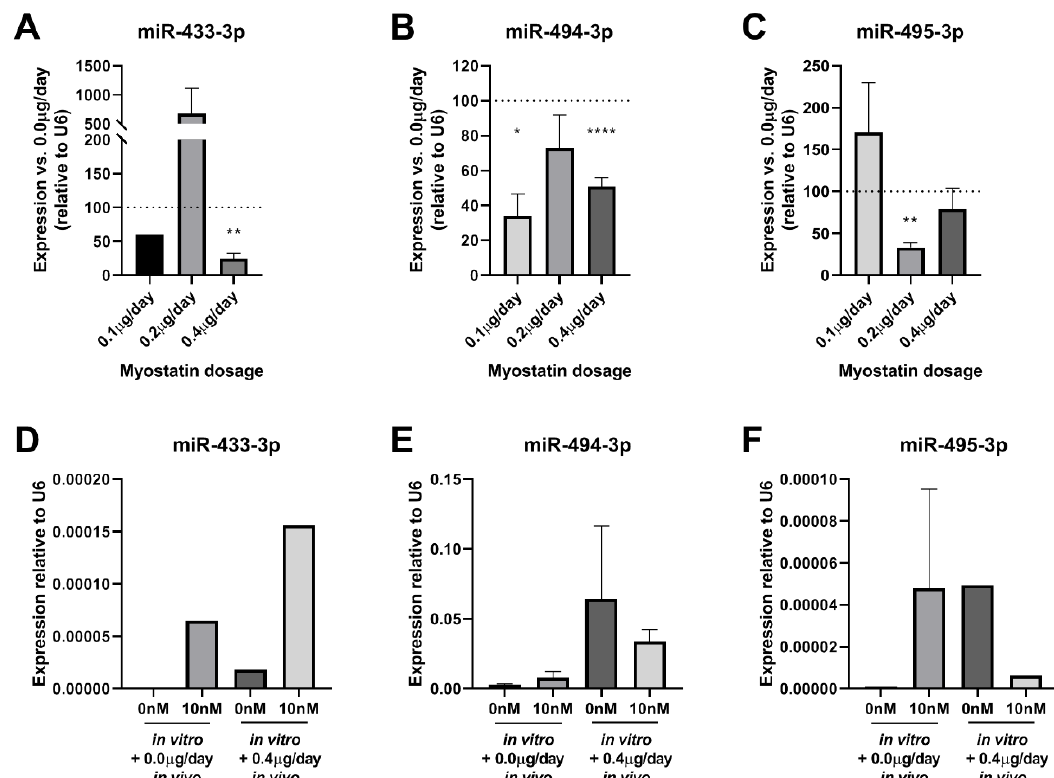
Figure 8. ( A – F) : microRNA expression in femoral arteries and macrophages. ( A )—miR-433-3p expression in femoral arteries of 0.1, 0.2, 0.4 µ g / day of myostatin relative to control mice (100%) showed significant downregulation of miR-433-3p at 0.4 µ g / day ( p = 0.003). ( B )—miR-494-3p expression in femoral arteries of 0.1, 0.2, 0.4 µ g / day of myostatin relative to control mice (100%) showed significant downregulation of miR-494-3p at 0.1 ( p = 0.001) and 0.4 µ g / day ( p < 0.0001). ( C )—miR-495-3p expression in femoral arteries of 0.1, 0.2, 0.4 µ g / day of myostatin relative to control mice (100%) showed significant downregulation of miR-495-3p at 0.2 µ g / day ( p = 0.0003). For ( A –C) Mean expression is shown and error bars represent SEM ( n = 8 for 0.0, 0.1 and 0.4 treatment groups, n = 6 for 0.2 treatment group). One-sample t-test performed with 100% expression of control group. * p < 0.05, ** p < 0.01, **** p < 0.0001. ( D )—miR-433-3p expression did not show any di ff erences between groups. ( E )—miR-494-3p expression did not show any di ff erences between groups. ( F )—miR-495-3p expression did not show any di ff erences. For ( D – E ) bone marrow monocytes matured into macrophages from in vivo treated mice with 0.0 vs. 0.4 µ g myostatin / day and in vitro treated without myostatin or with 10 nM myostatin. Maturated cells were stimulated with LPS to trigger an inflammatory reaction. Mean expression is shown as average of duplicate measurements of pooled macrophages and error bar represents SEM. Wilcoxon rank sum test did not show any di ff erences.